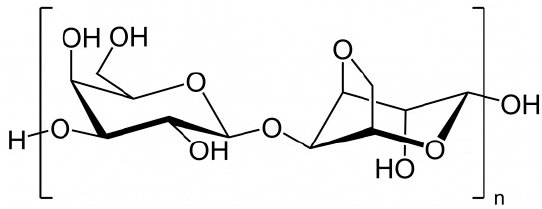
Figure 1. Idealized structue of the chemical units of Agar.